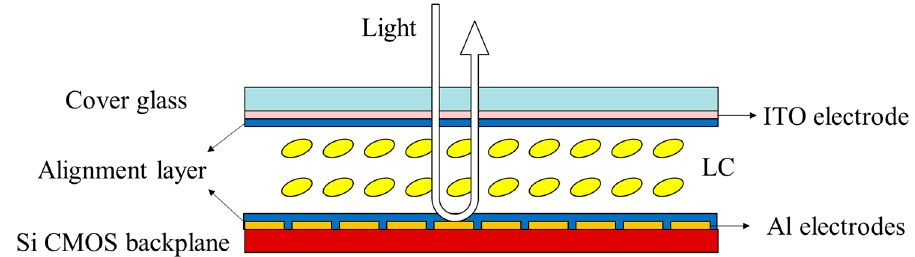
Figure 1. The schematic of a LCoS structure.